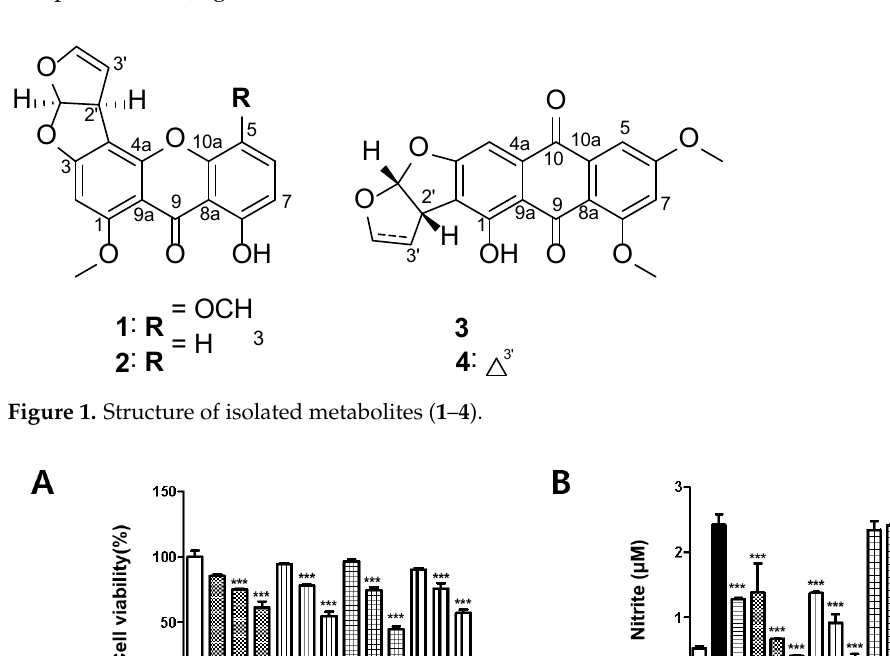
Figure 1. Structure of isolated metabolites ( 1 – 4 ).